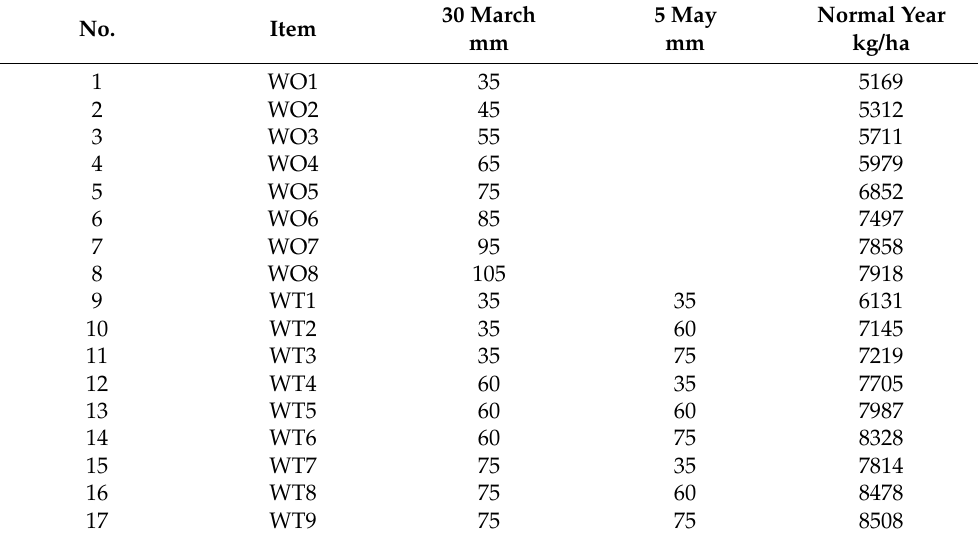
Table 10. Yield simulation of the B2 scenario in the piedmont plain